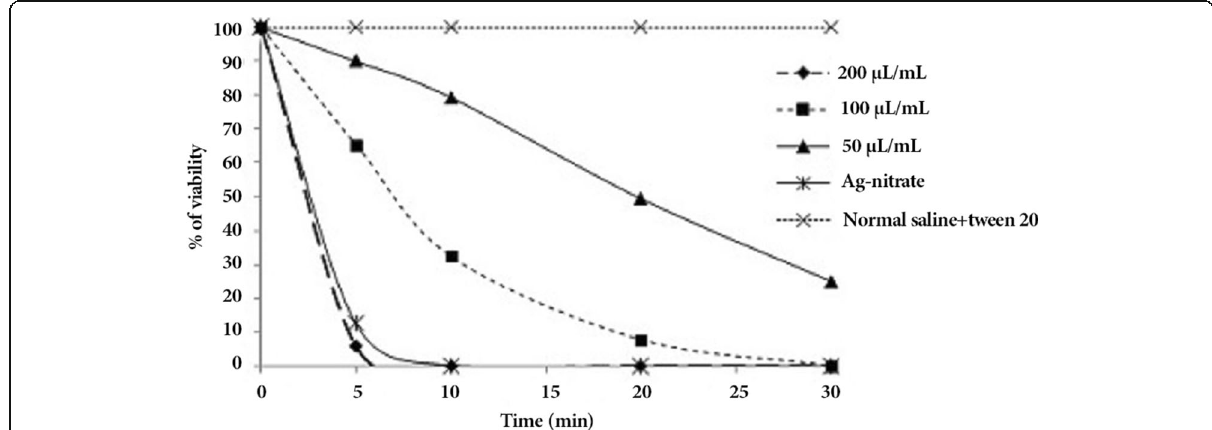
Fig. 2 Ex vivo protoscolicidal effects of C. longa essential oil against protoscoleces of hydatid cyst at various concentrations following various exposure times